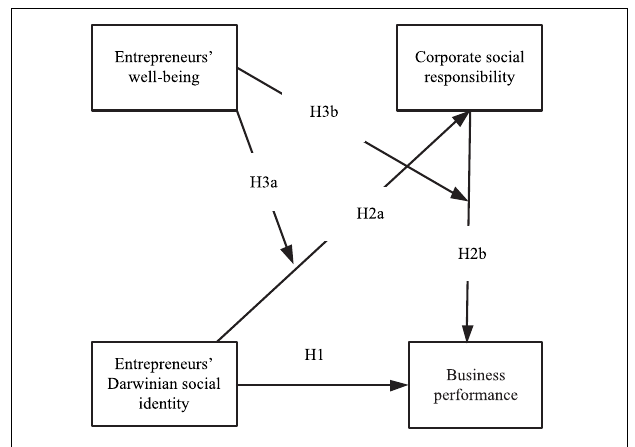
FIGURE 1 | Conceptual